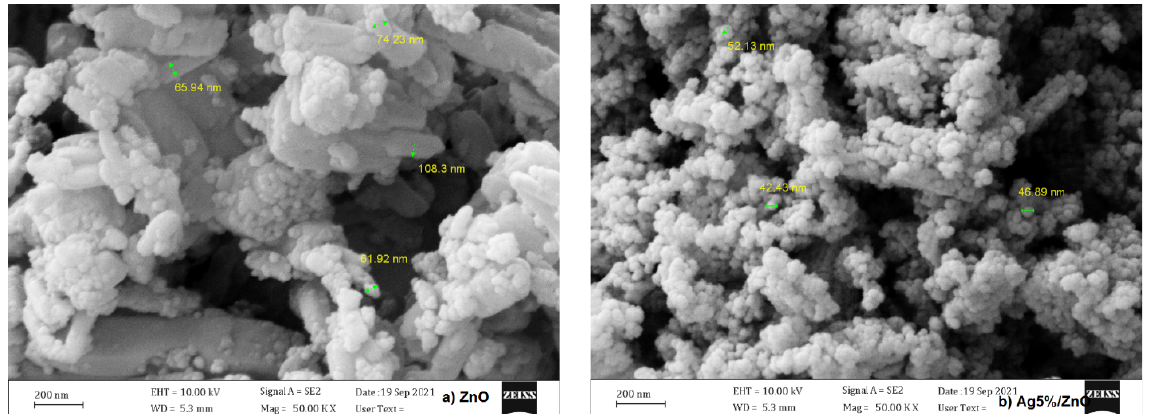
Figure 2. FE-SEM images of nanoparticles synthesized using sol-gel process (a) Zinc Oxide (ZnO) and (b) Silver (Ag) 5%/ZnO